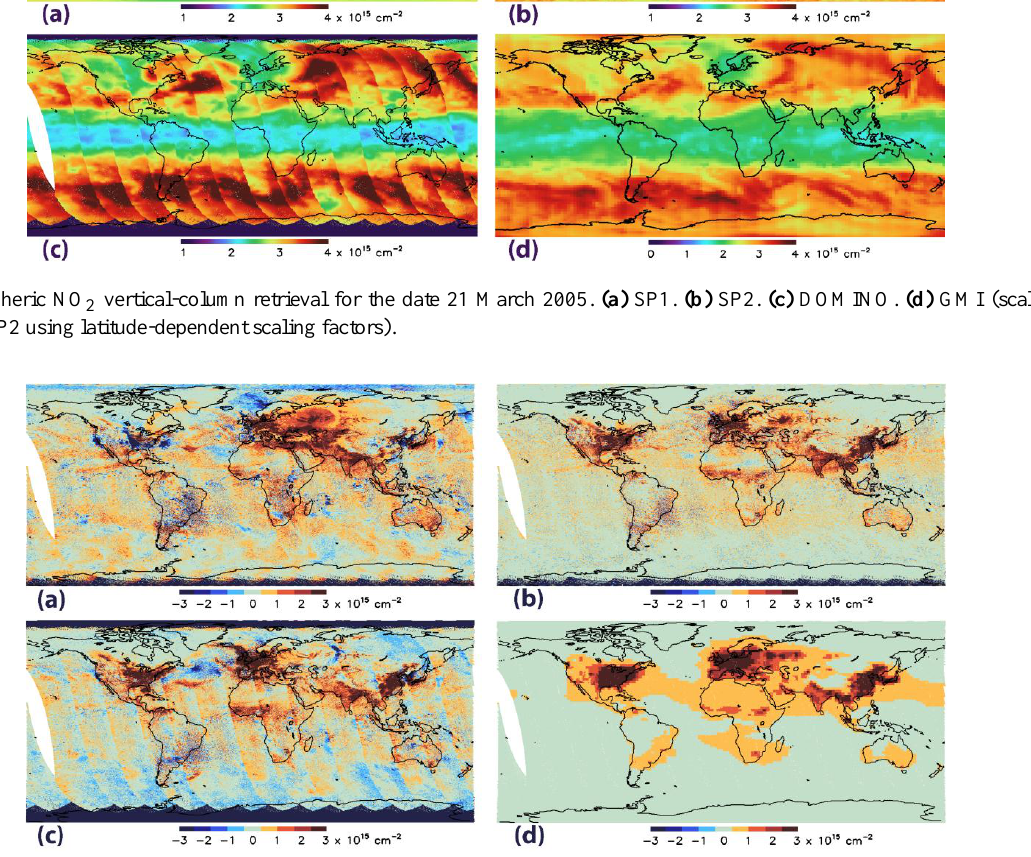
Fig. 8. Tropospheric NO 2 vertical-column retrieval for the date 21 March 2005. (a) SP1. (b) SP2. (c) DOMINO. (d) GMI. Note that all negative values in SP1 were set to zero in the original SP1 public product. Also note that most of the negative values in the DOMINO product occur in cloudy or snow-covered regions and are flagged as unreliable.